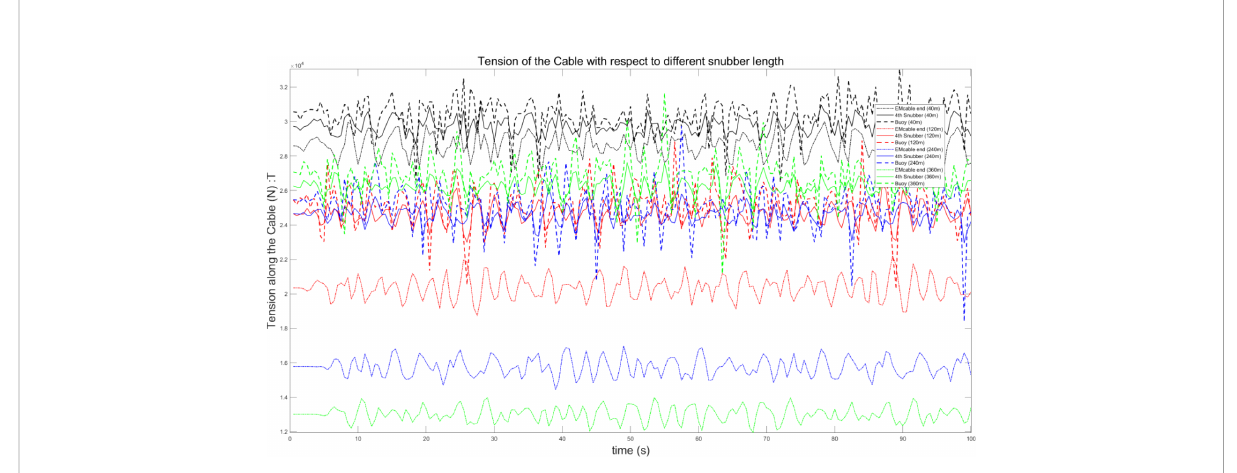
FIGURE 12 Dynamic tension for various components for different lengths of snubber for a Nilspin cable with the snubber up.